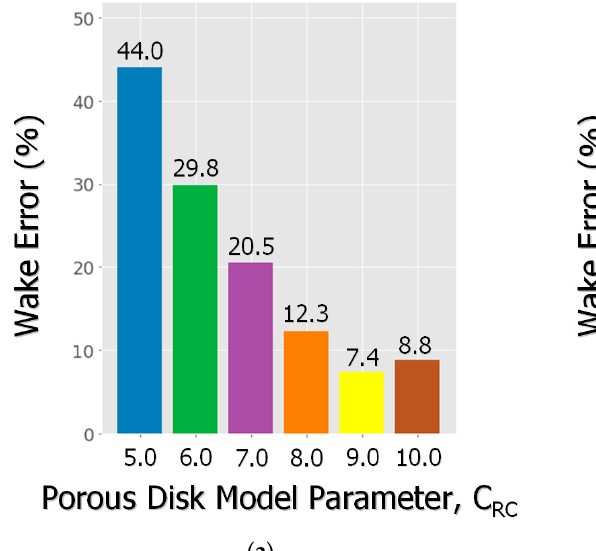
Figure 20. Comparison of vertical distribution of time-averaged U-velocities. ( a ) x = 5D (near wake region); ( b ) x = 10D (far wake region). Simulation results of a time-averaged field for a real wind turbine shown here.